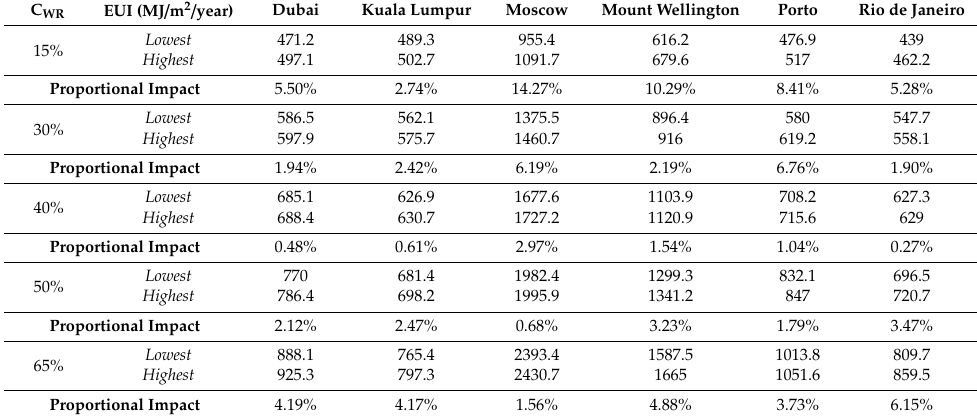
Table 5. The proportional impact of the construction components of walls and roofs on the EUI in the case study based on window-to-wall